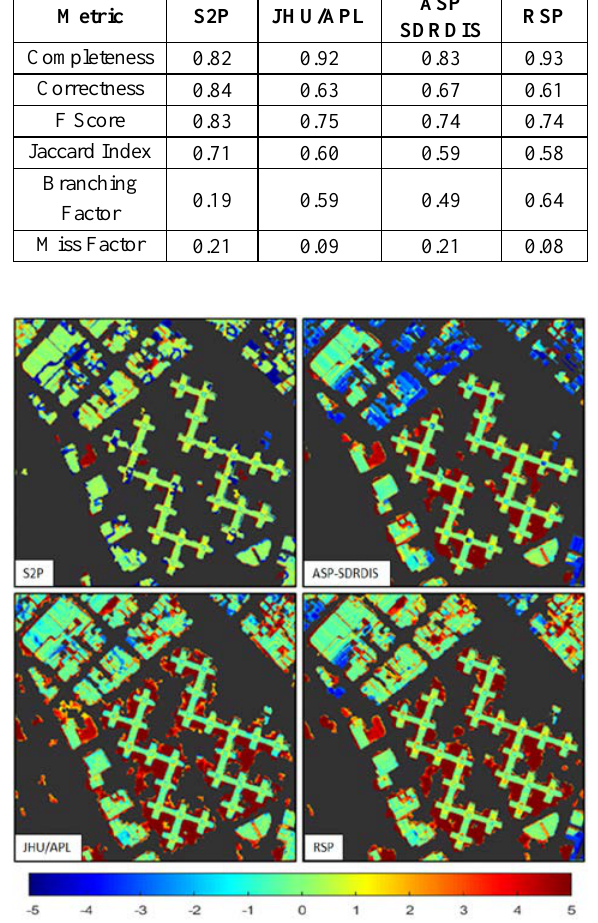
Figure 8 3D building height accuracy is shown for labeled MVS point clouds (height color scale is shown in